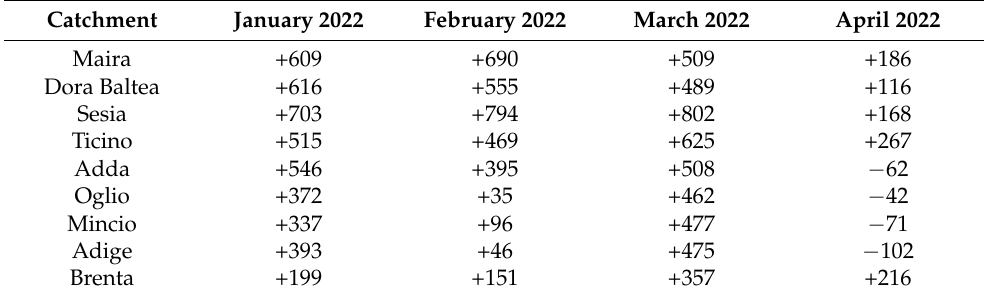
Table 1. Deviation of the SLE in early 2022 from the long-term (1985–2021) median in meters. See Supplementary Table S1 for all months of the hydrological year 2021/22.